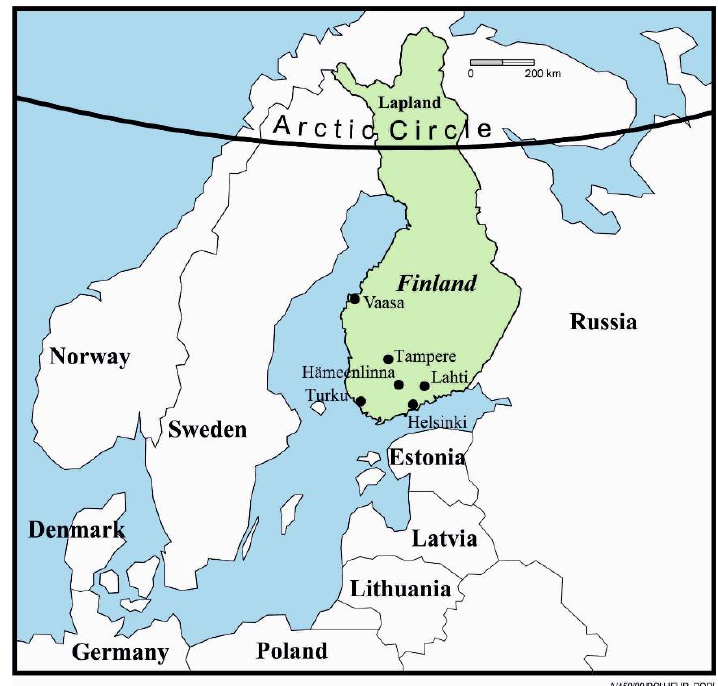
Figure 1. Locality map of Finland.